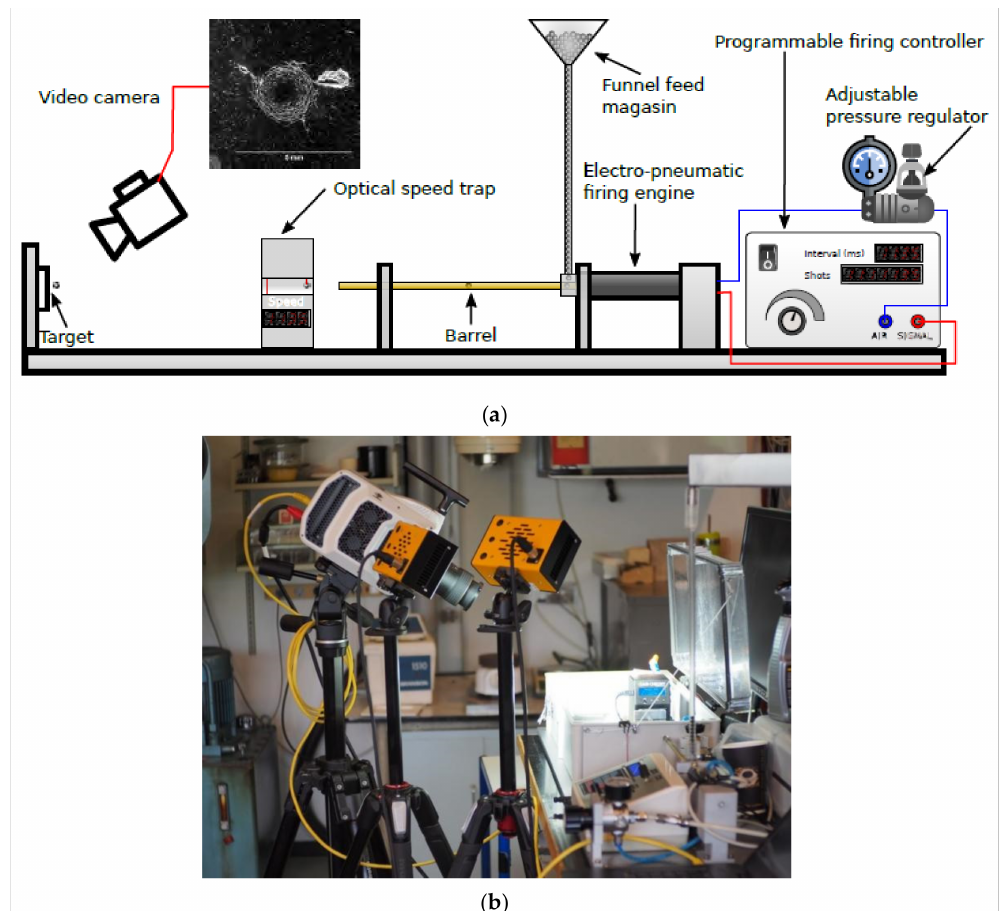
Figure 2. ( a ) The Single Point Impacts Fatigue Tester (SPIFT) erosion testing setup. ( b ) High speed camera (Phantom v2512 fast) for filming the ball impacts at 380,000